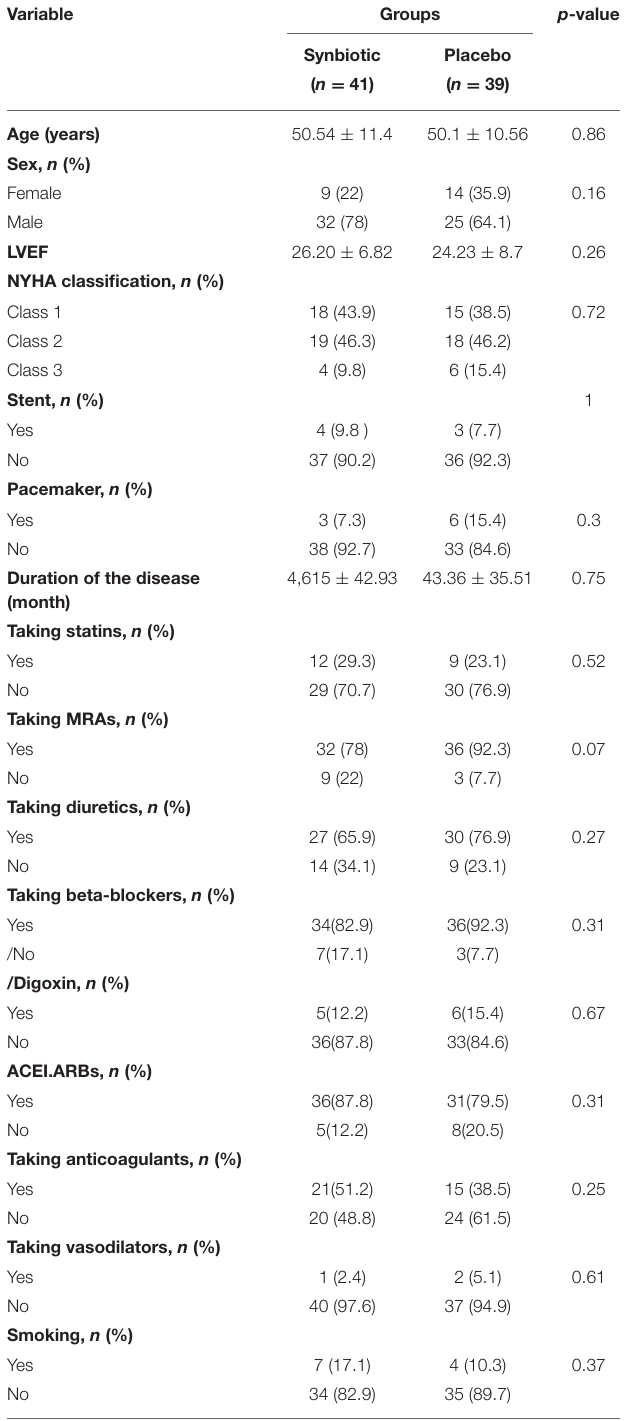
TABLE 1 | Individual characteristics of study participants. Variable Groups p -value